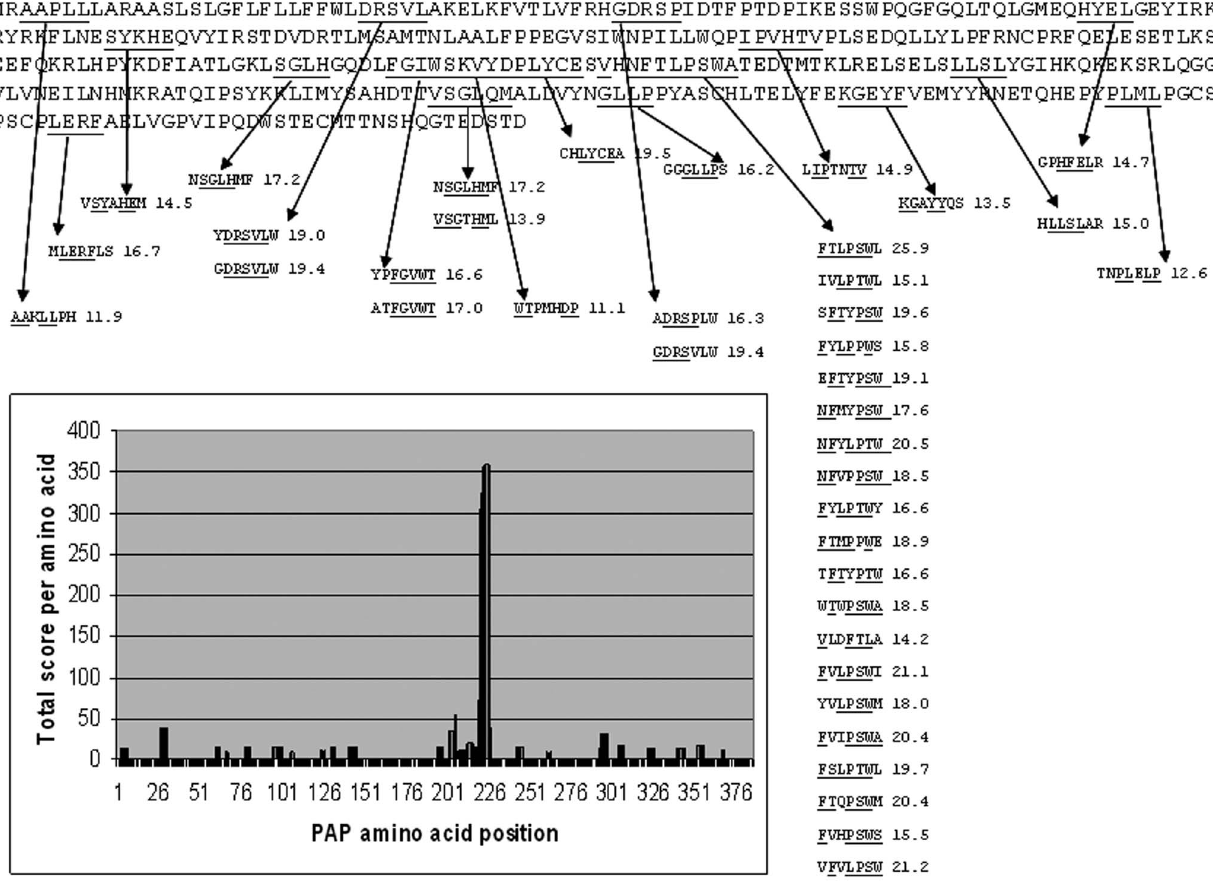
Figure 1. Epitope profile of the PAP protein generated by PAP1 mouse antiserum. ( A ) The NP_001090.2 PAP variant amino acid sequence and the 40 matching peptides with the highest match scores generated by bl2seq program are shown. The sequences of the protein matching to peptides and the corresponding peptide sequences that match to protein are underlined. B . The graphic shows the distribution of the total score of the peptide matching over the sequence of the PAP protein.